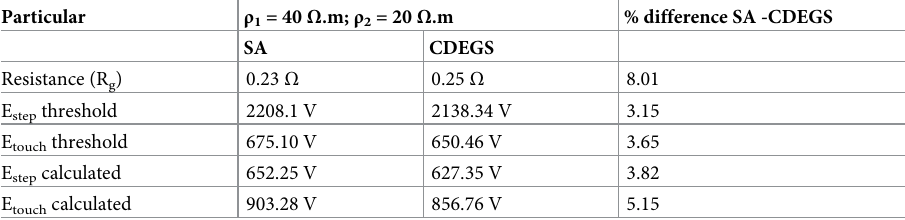
Table 11. Results for grounding system in vertical two-layer soil ( ρ 1 > ρ 2 ).